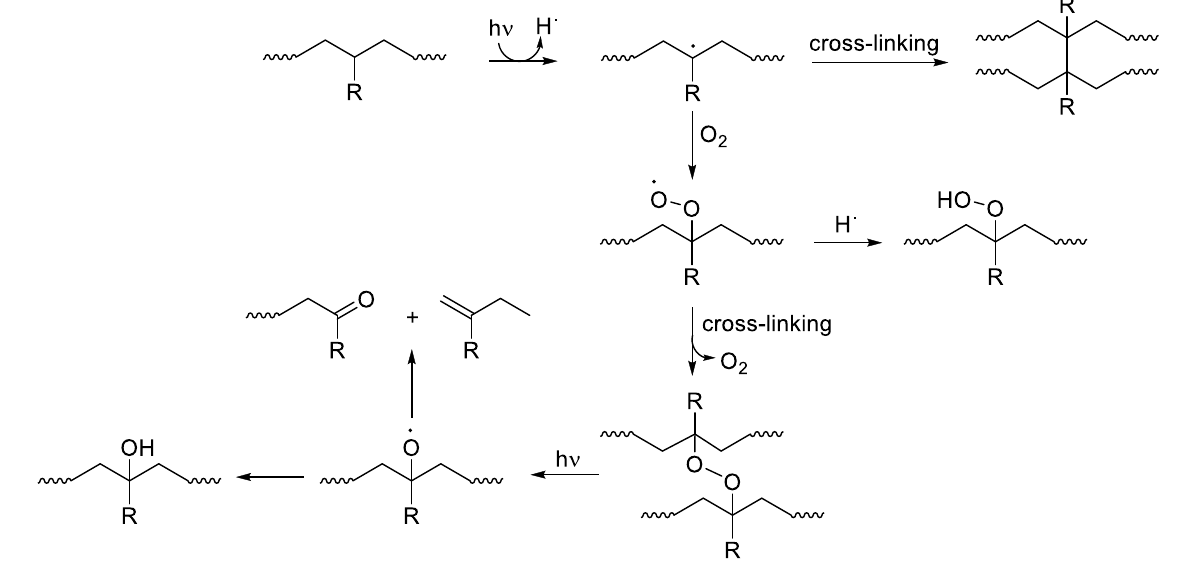
Figure 1. Abiotic degradation pathways for PE (R = H), PP (R = Me), and PS (R =